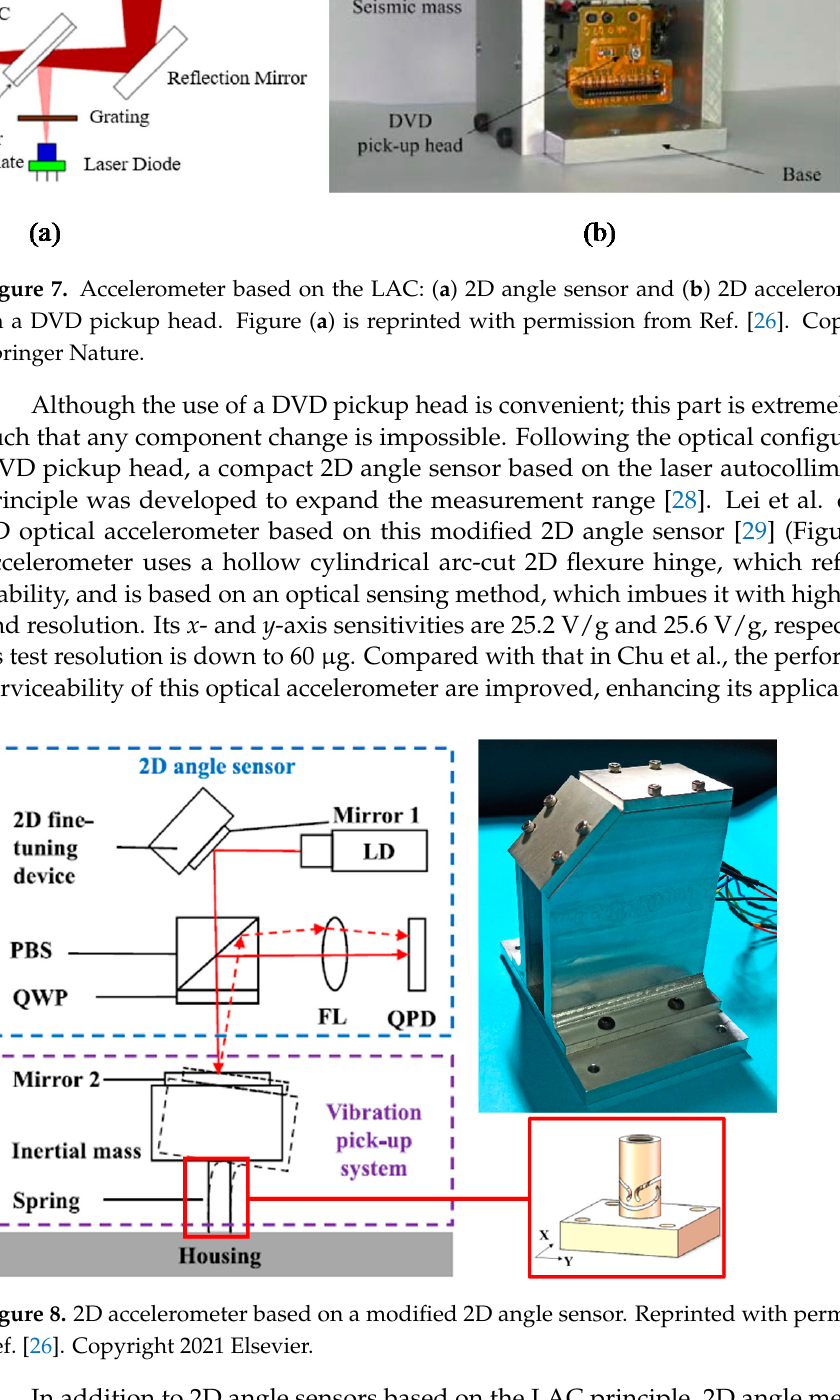
Figure 8. 2D accelerometer based on a modified 2D angle sensor. Reprinted with permission from Ref. [26]. Copyright 2021 Elsevier.